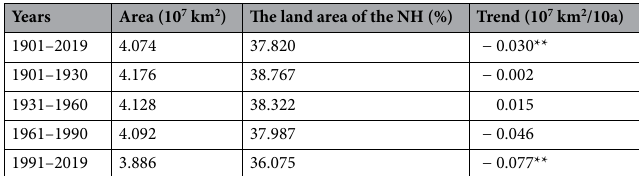
Table 1. The mean area of the cold regions and its variation in the NH from 1901 to 2019. “*” and “**”: P < 0.01 and 0.001, respectively.